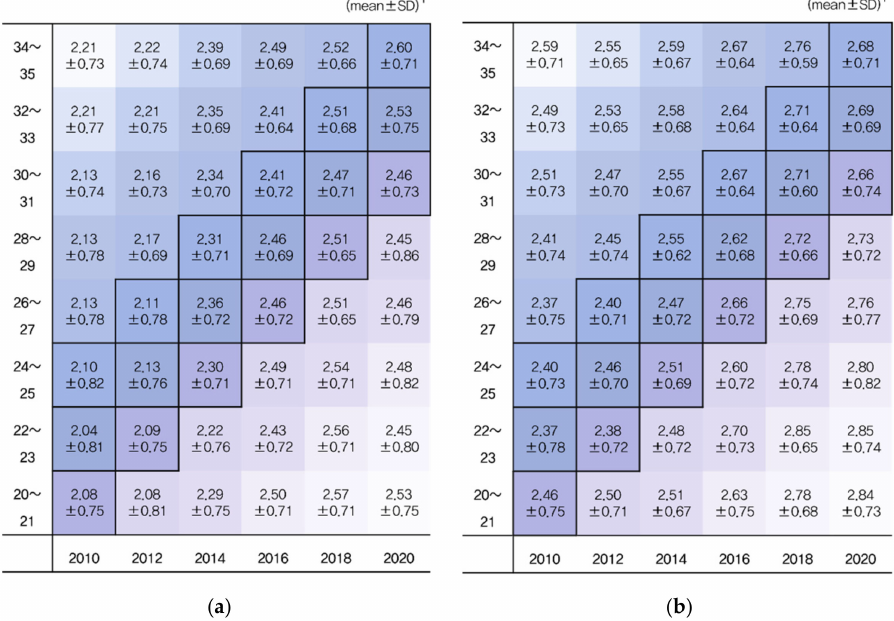
Figure 2. Marriage intention scores of unmarried young adults aged 20–35 according to gender: ( a ) changes in the marriage intention of men and ( b ) changes in the marriage intention of women. 1 Scoring for the “intention on marriage” question: 1 point “must do” to 5 points “should